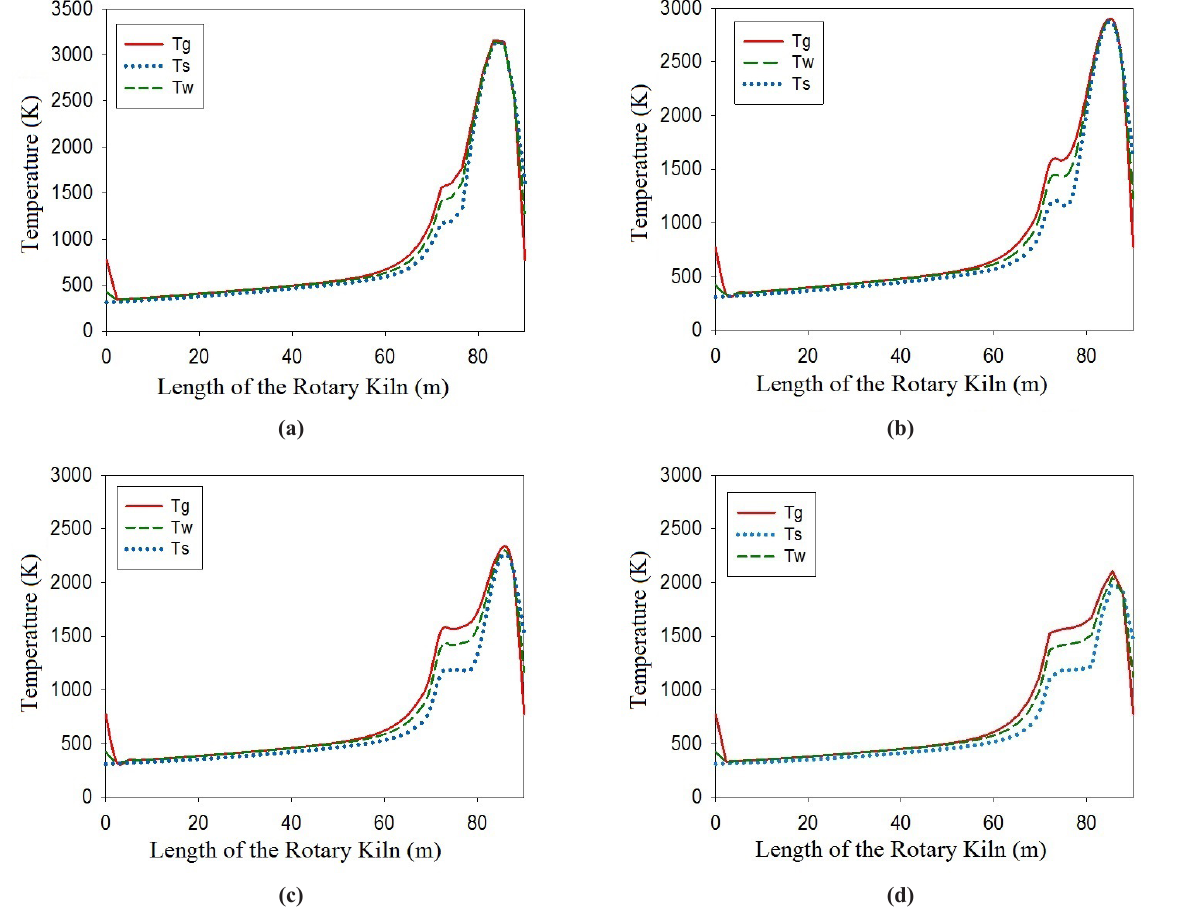
Figure 5 - Temperature profiles of the gas, the solid, and the wall of the industrial rotary kiln at steady state. ( a ) -20% of inlet solid speed; ( b )-10% of inlet solid speed; ( c ) +10% of inlet solid speed; ( d ) +20% of inlet solid